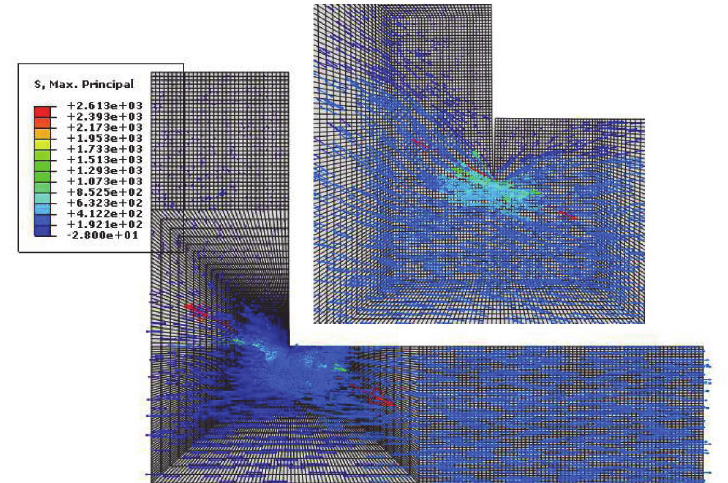
Figure 10: Maximum principal stress directions for case